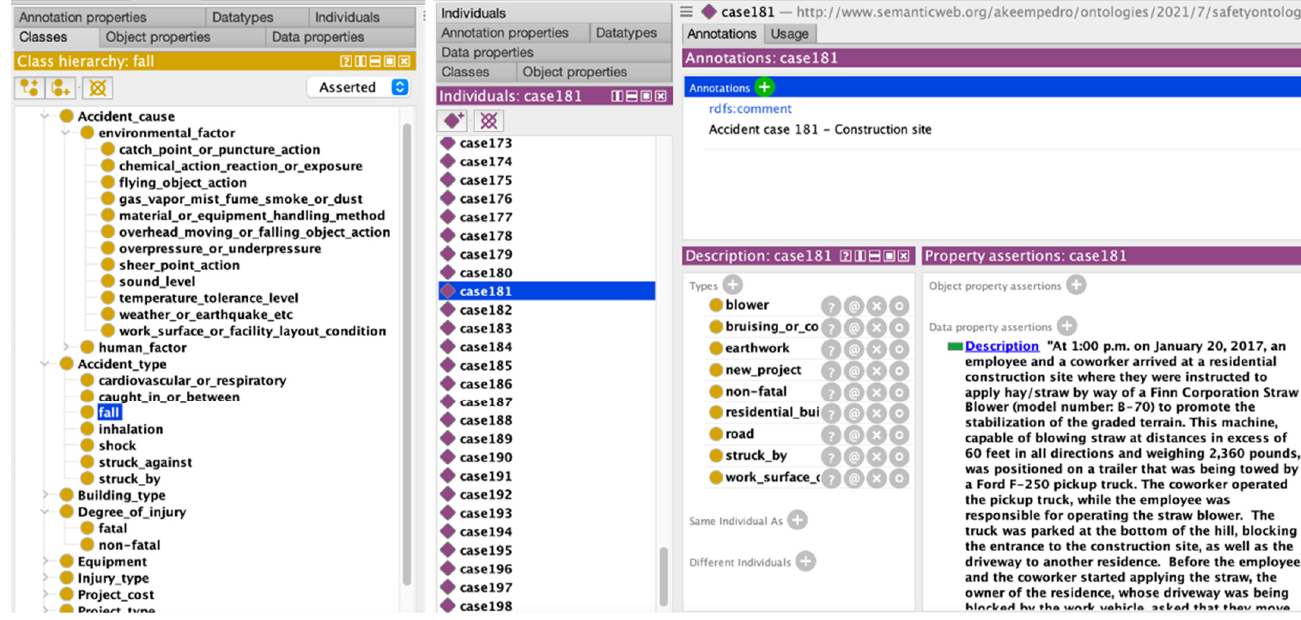
Figure 5. Ontology for construction safety information sharing.